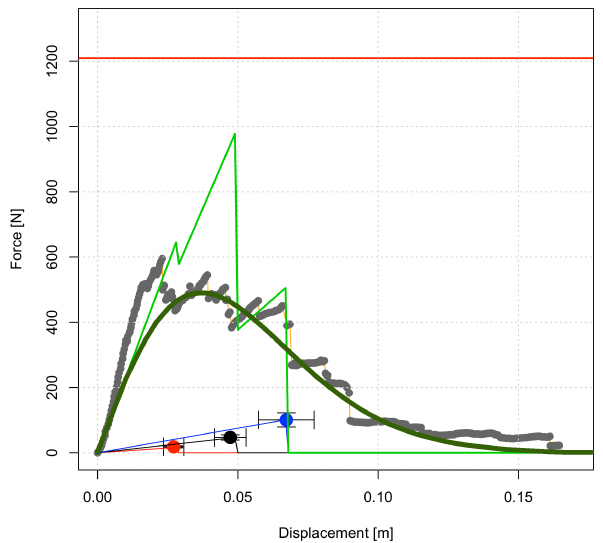
Fig. 6. Measured and simulated force-displacement behavior of a bundle of roots. The gray points (linked by the orange line) are the measured data of field pullout experiments (Schwarz et al., 2011) for a root bundle composed by 7 roots of 0.001m diameter, 13 roots with 0.002m diameter, and 5 roots with 0.003m diameter. The green lines show the prediction of the RBMw considering two values of the Weibull exponent, 100 (light green) and 2 (dark green). The red-black-blue lines and points show the behaviors of the sin- gle roots, as link to Fig. 4. The continuous red line on the top of the plot indicates the estimated value of root reinforcement using the Wu model (Wu et al., 1979).